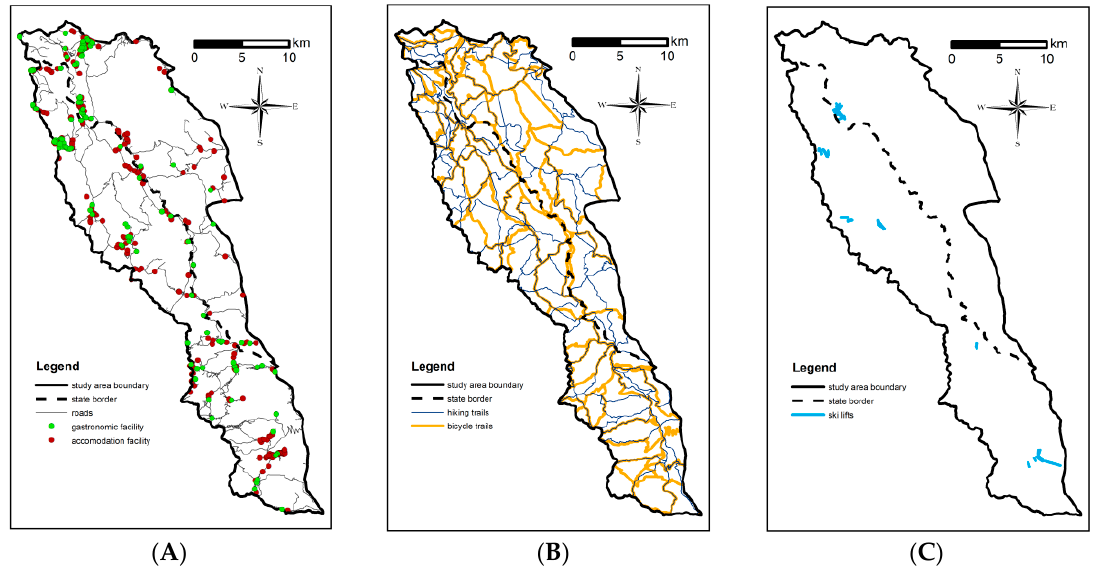
Figure 4. The analyzed tourism infrastructure in the study area: ( A ) accommodations, gastronomic facilities, and roads; ( B ) marked hiking and cycling trails; ( C ) ski-lifts. Source: authors’ own research.